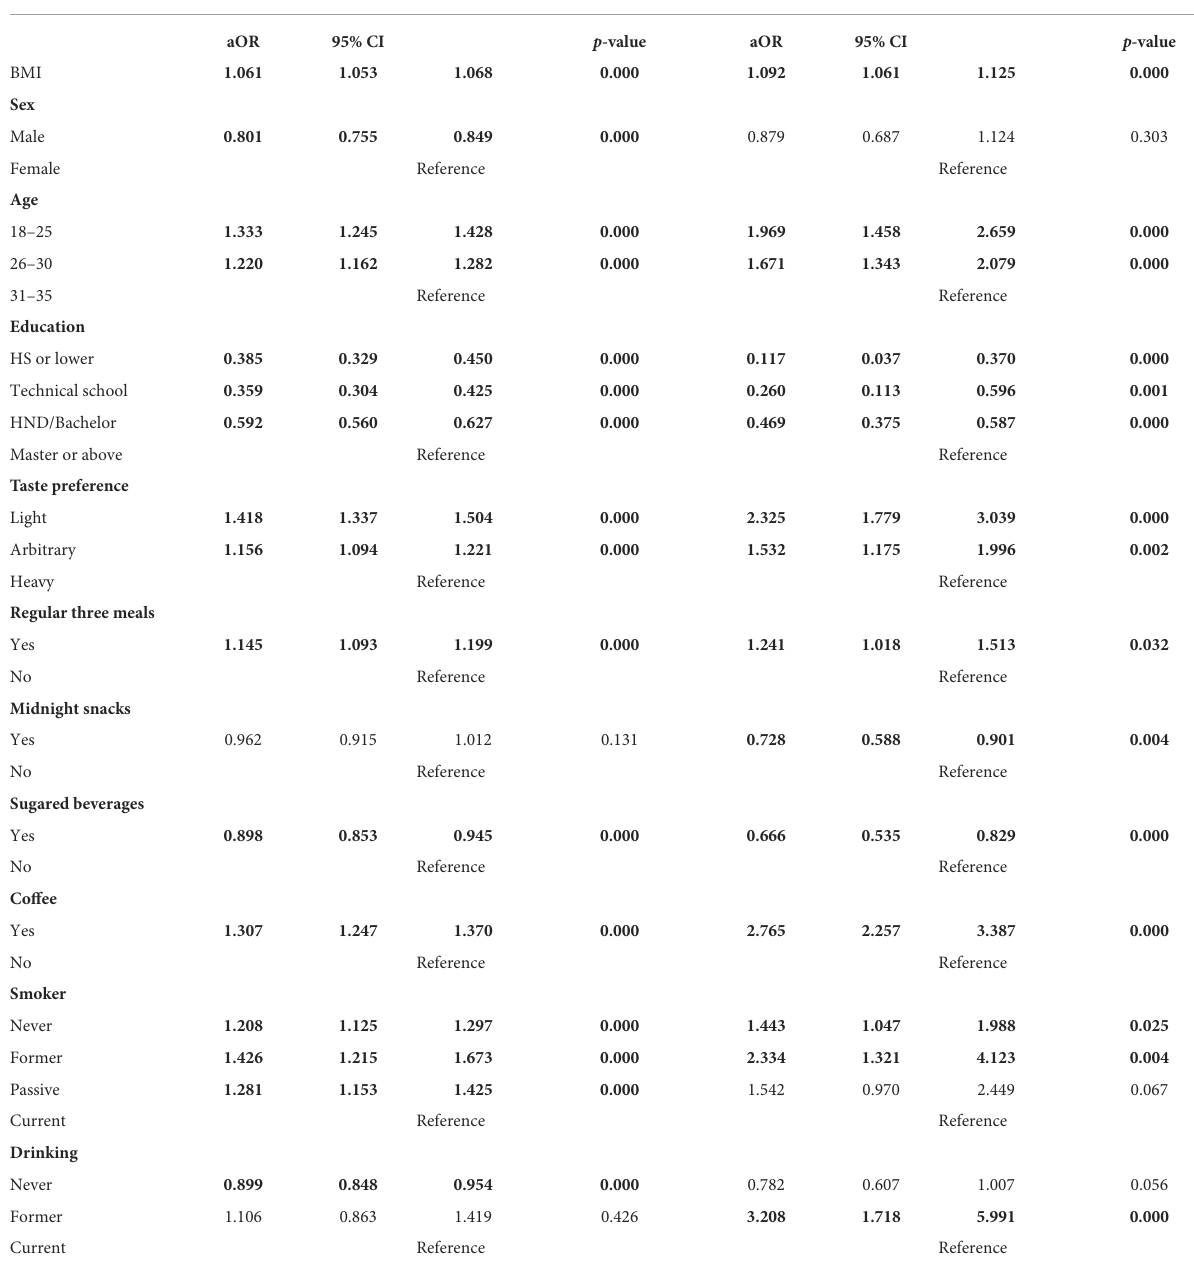
TABLE 4 Adjusted multinomial logistic regressions a of dietary diversity on independent variables ( n = 49,021).